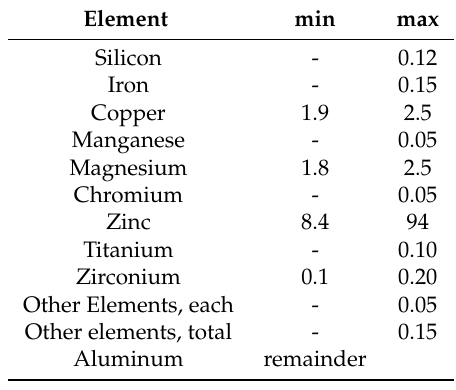
Table 2. Al7136 composition according to AMS2355